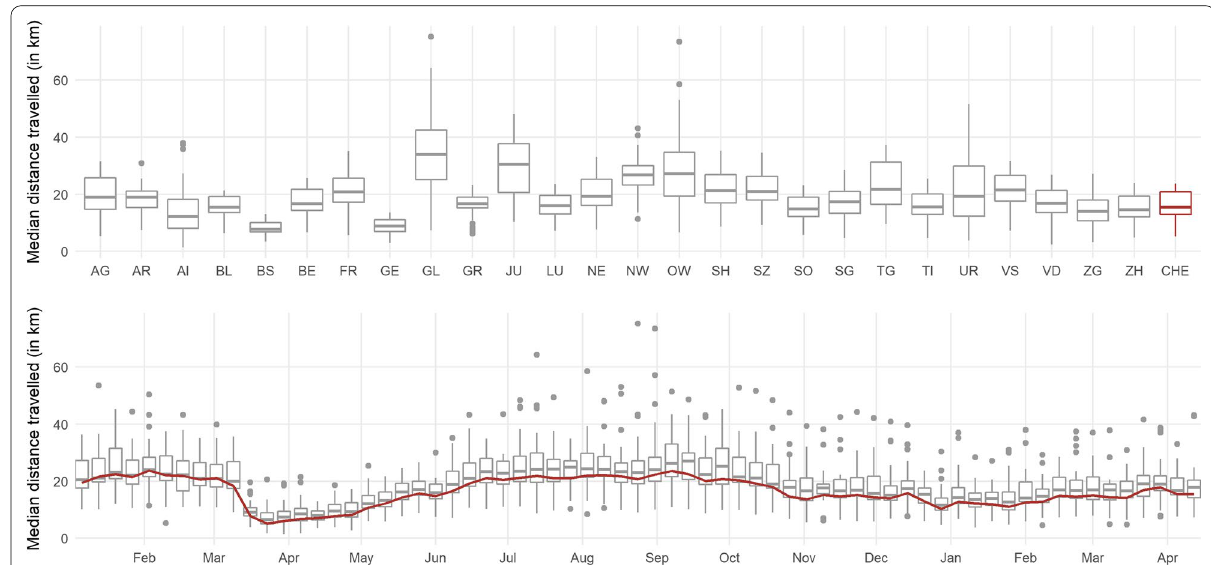
Fig. 6 Mobility. Mobility is measured as the median distance in kilometers travelled by a sample of tracked cell phone users. The upper and lower parts show box plots grouped at the canton level and across cantons at the weekly level, respectively. National figures are shown in red. The